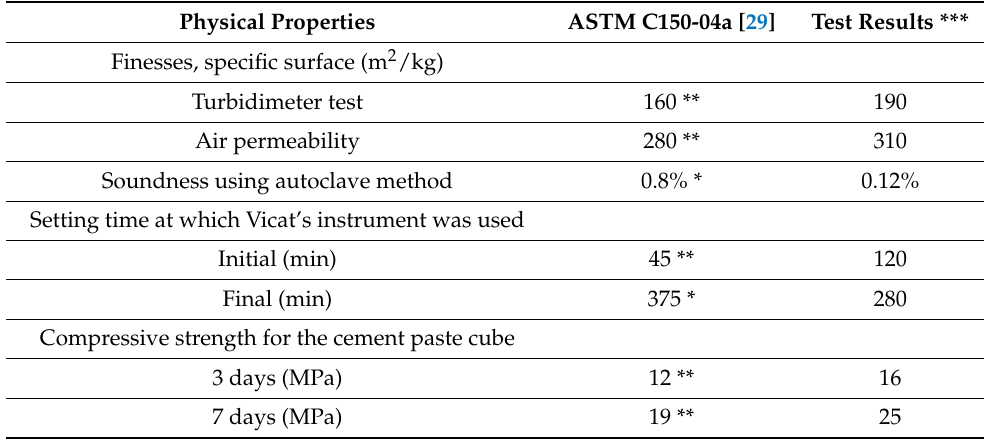
Table 2. Physical composition of the cement.